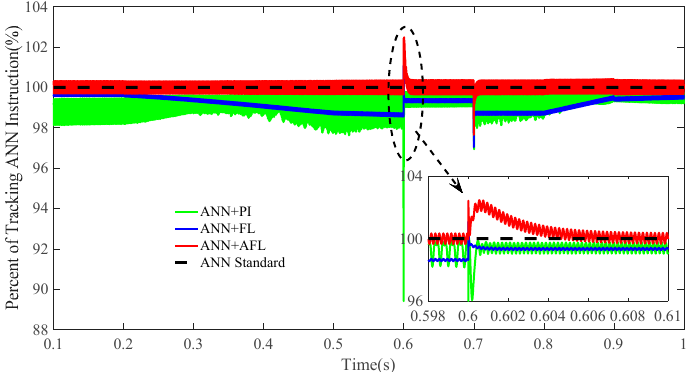
Figure 12. Output of each method divided by the ANN reference.